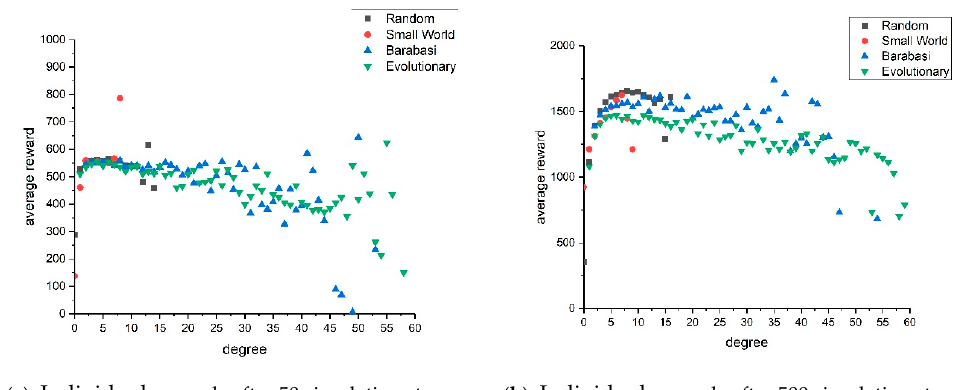
Figure 5. Average individual reward of firms for different degrees.